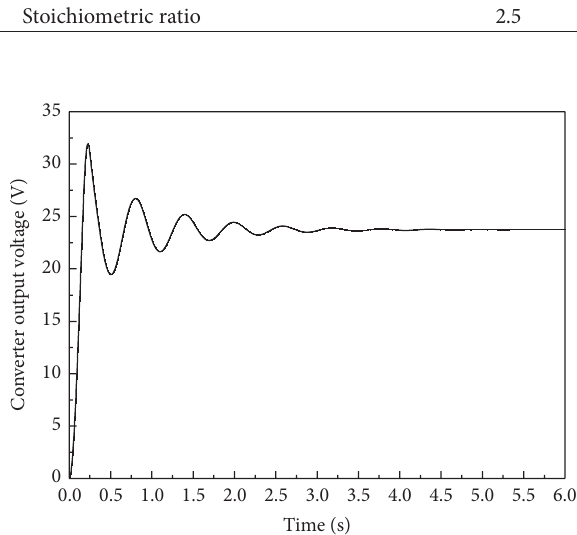
Figure 4: Output voltage of DC-DC buck